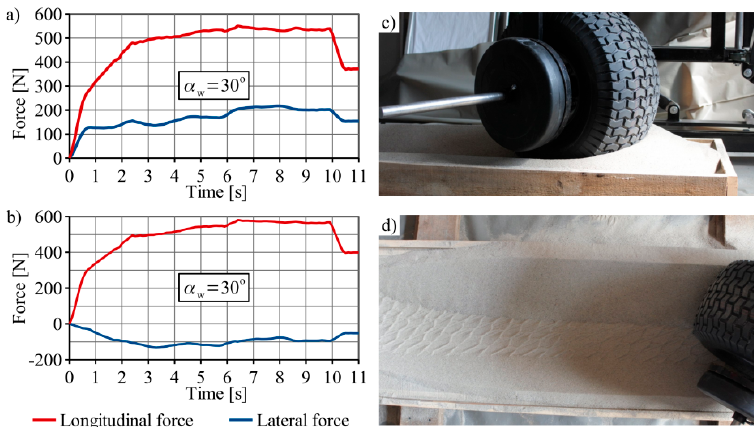
Figure 4. Graphs of the measured longitudinal and lateral forces relative to the direction of movement ( a ), as well as the calculated longitudinal and lateral forces relative to the geometry of the wheel ( b ), for α w = 30 ◦ . The wheel on the experimental stand after the test ( c ), and the resulting tire track ( d ) [21]. The longitudinal force increased with the angle of attack, and was similar for the values 60 ◦ and 90 ◦ . For the 60 ◦ angle, the wheel’s speed decreased; this can be seen in the photos that show the tire track, where the pattern of the wheel’s tread cannot be seen in the track. The lateral force for the angles 0 ◦ and 90 ◦ was